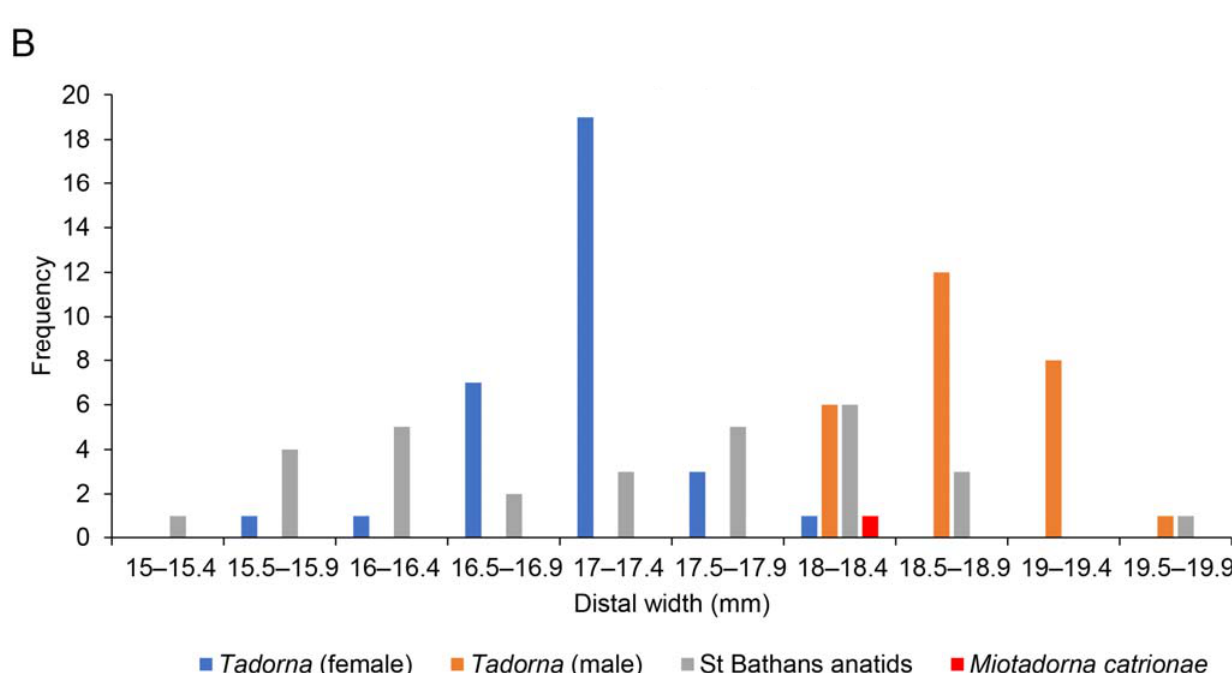
Figure 2. Frequency of humeral proximal depth ( A ) and distal width ( B ) in Tadorna variegata and large St Bathans anatids, indicating sexual dimorphism (bimodal distributions) in T. variegata and probably in the St Bathans anatids.